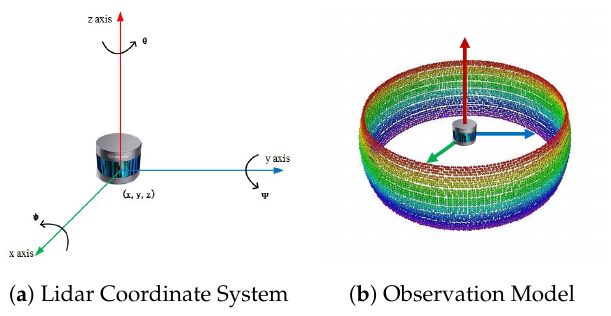
Figure 2. 3D Omni-Direction Lidar